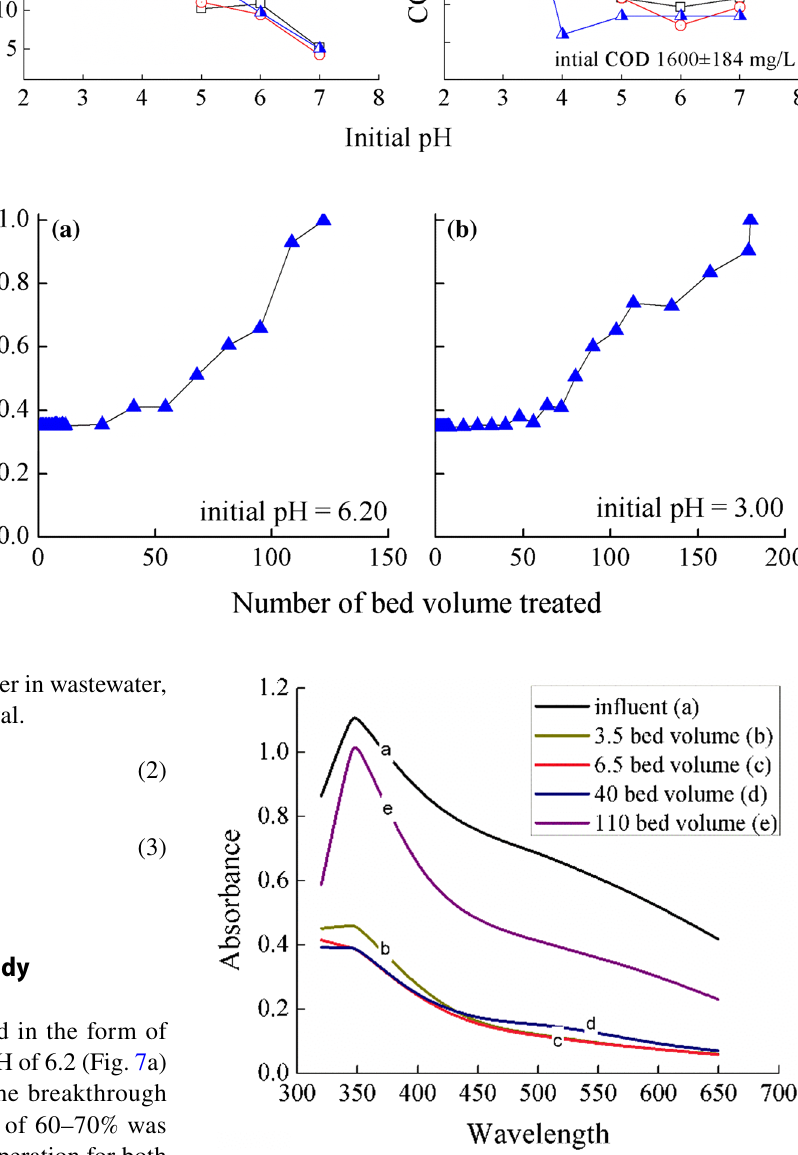
Fig. 8 Spectral variation of wastewater at different bed volume